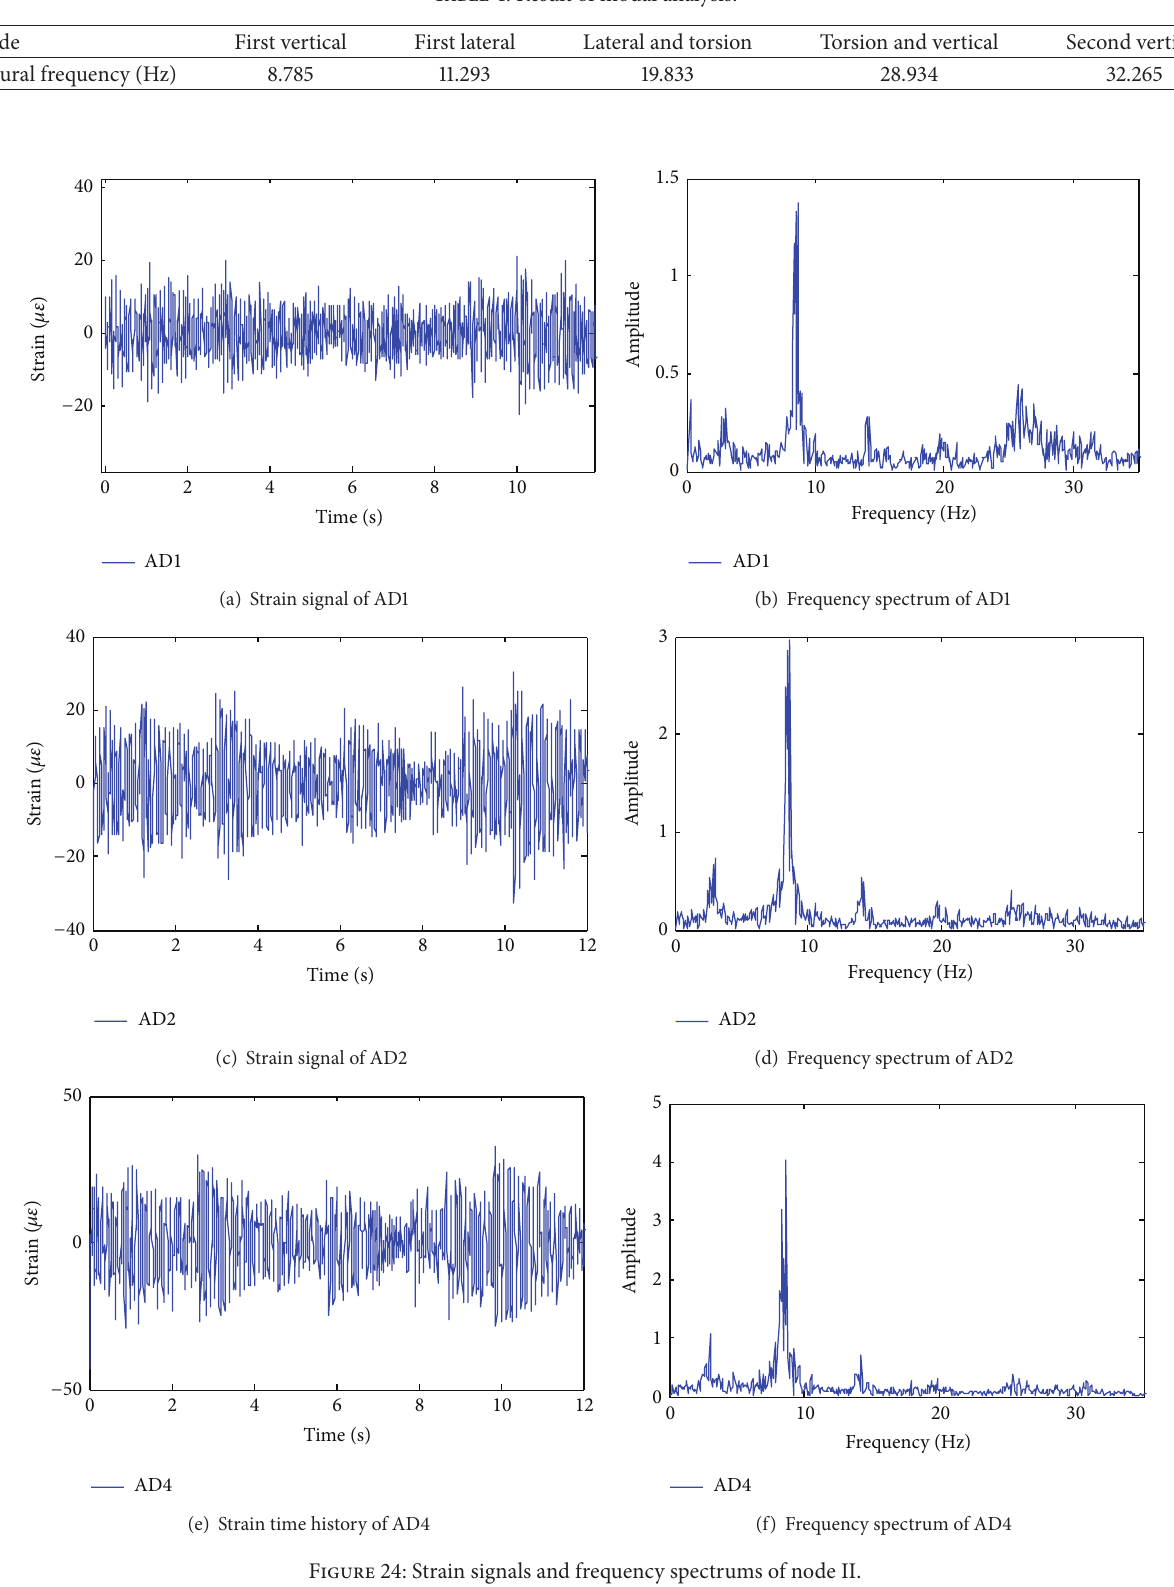
Figure 24: Strain signals and frequency spectrums of node